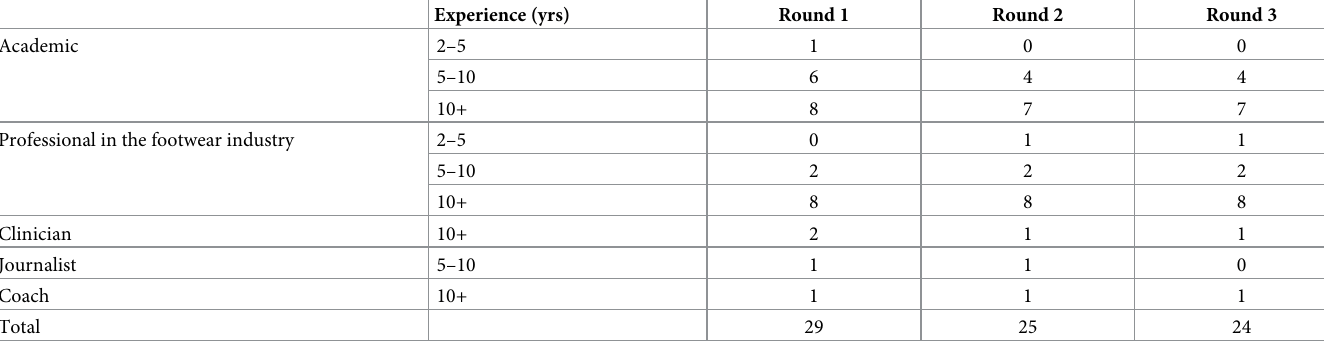
Table 2. Number of participants and their experience investigating/designing